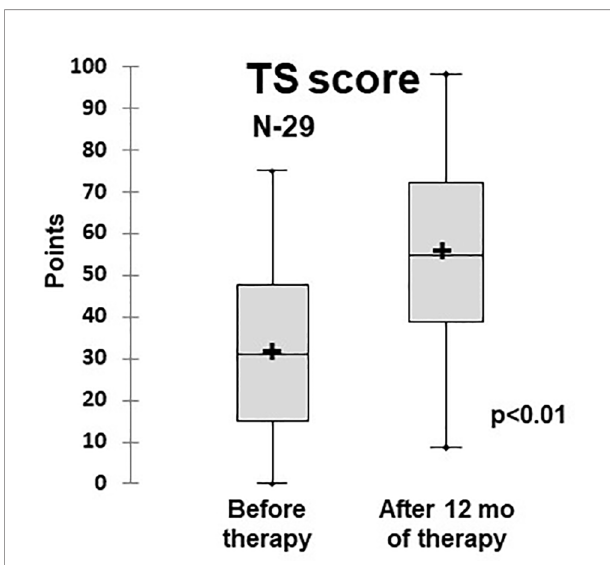
FIGURE 6 | Dynamics of the quality of life (total scale score) in ILLD patients treated with abatacept or rituximab (PedsQL 4,0). N- number of